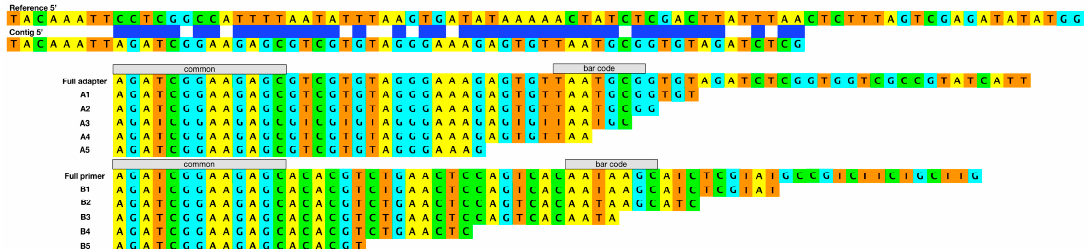
Figure 1. Examples of the Illumina adapter and primer fragments found attached to terminated contigs. The sequences are displayed 5 ′ > 3 ′ . The top two sequences represent the reference variola virus (VARV) genome with the end of a contig immediately below it. At the left, the reference and contig match perfectly; the blue boxes show a region of mostly mismatching single nucleotide polymorphisms (SNPs) due to the adapter, which terminates the contig. The full adapter and primer sequences are shown with examples of fragments of adapters (A1–A5) and fragments of primers (B1–B5) found to terminate contigs.